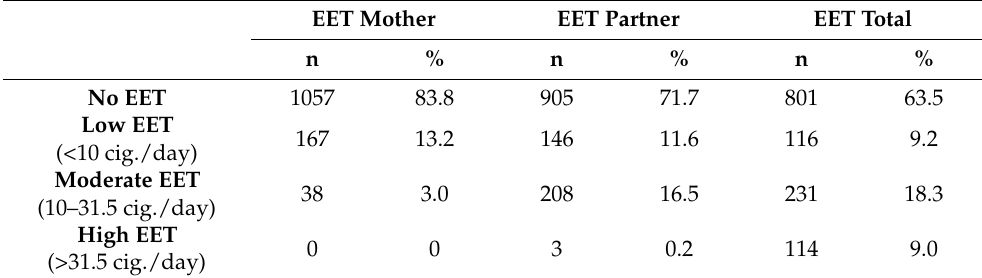
Table 2. Calculated levels of environmental exposure to tobacco during